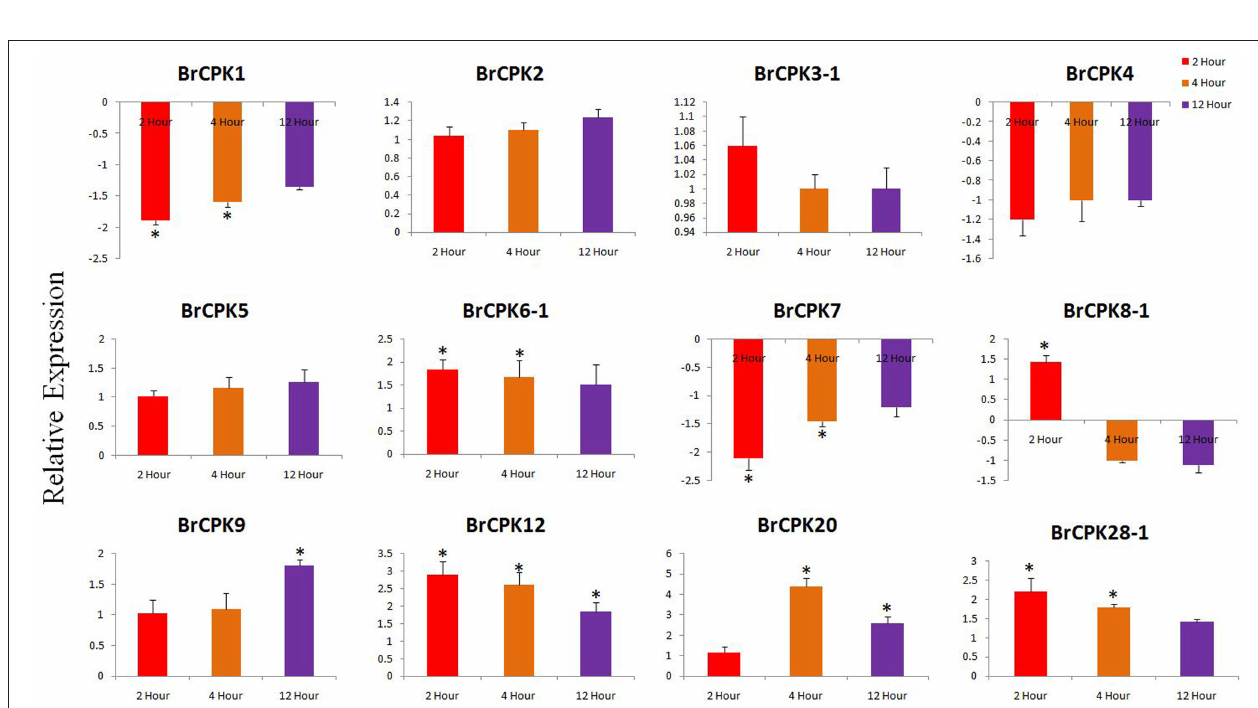
FIGURE 6 | Quantitative real time PCR of cold treated B. rapa CPK genes at 2, 4, and 12h. The transcript levels of BrCPKs were normalized with ACT2 and expressed as fold change relative to normalized transcript level in leaves of control (untreated plants at respective time points) plants. The metric bar represents the standard errors (SE) and star indicates statistical significance at * p < 0.05 .